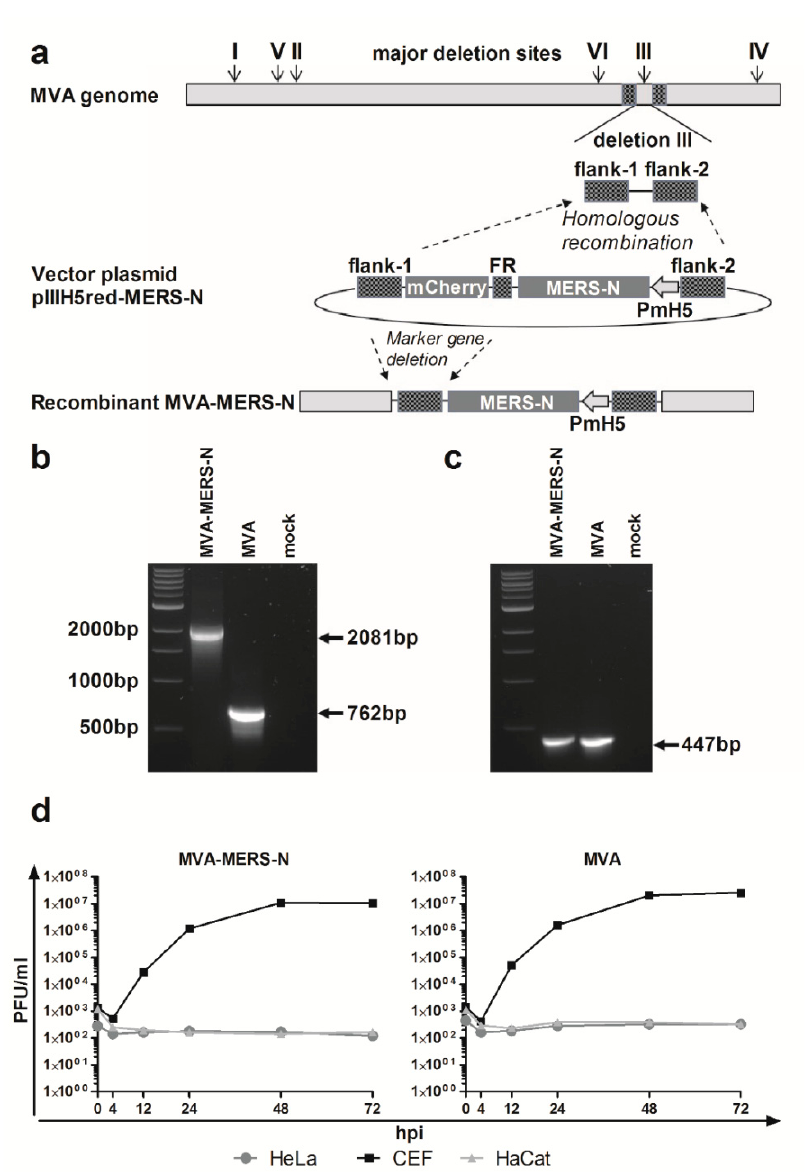
Figure 1. Generation and characterization of recombinant Modified Vaccinia virus Ankara expressing the Middle East respiratory syndrome coronavirus N protein (MVA-MERS-N); ( a ) Schematic diagram of the MVA genome indicating the major deletion sites I-VI on the top. Flank-1 and flank-2 refer to MVA DNA sequences adjacent to corresponding insertion site. Deletion III was used to insert MERS-N encoding gene sequences under the transcriptional control of the vaccinia virus promoter PmH5. Repetitive sequences (FR) were designed to remove the mCherry marker by intragenomic homologous recombination (marker gene deletion); ( b , c ) PCR analyses of genomic viral DNA using oligonucleotide primers to confirm the correct insertion of recombinant MERS-N gene into deletion III ( b ), and the genetic integrity of the MVA genome for the C7L gene locus ( c ); ( d ) Multi-step growth analysis of recombinant MVA-MERS-N and non-recombinant MVA (MVA); Chicken embryo fibroblasts (CEF) and human HaCat or HeLa cells were infected at a multiplicity of infection (MOI) of 0.05 with MVA-MERS-N or MVA. Infected cells were collected at different time points after infection and titrated on CEF